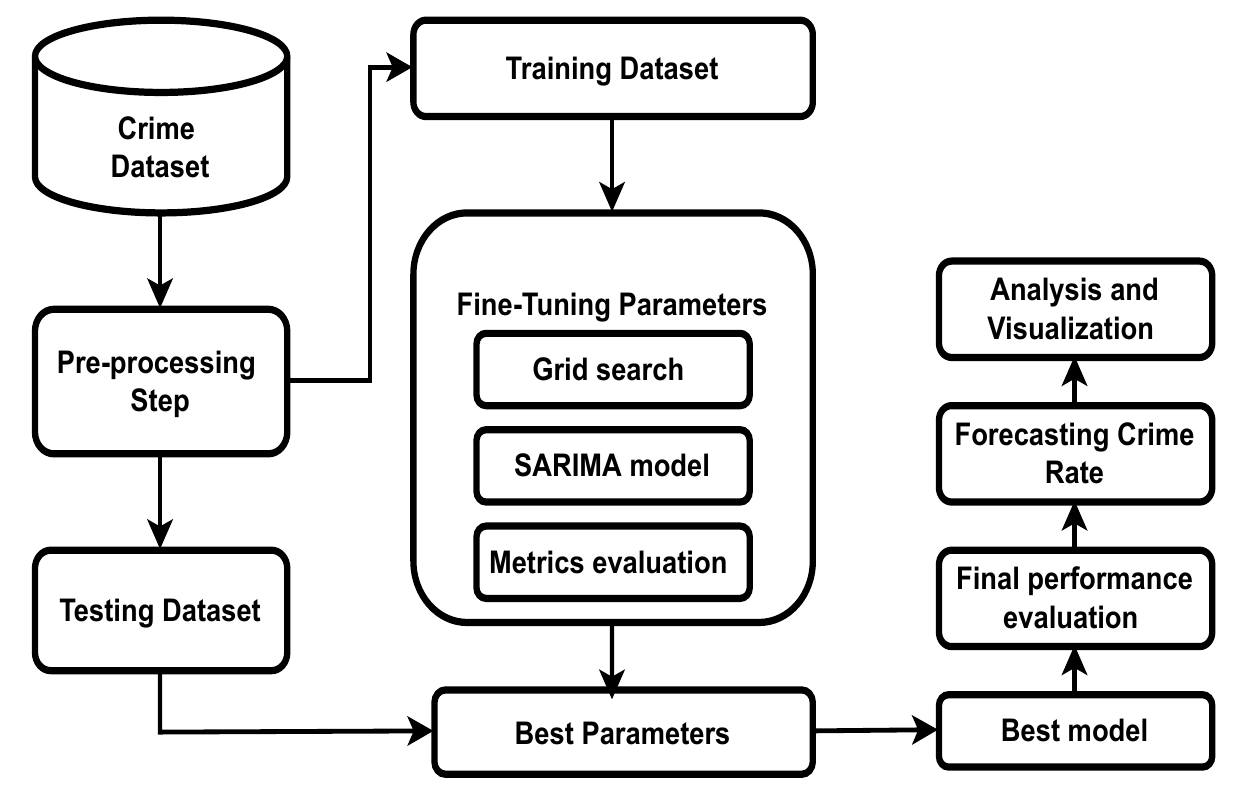
Figure 1. The main steps of the proposed framework.